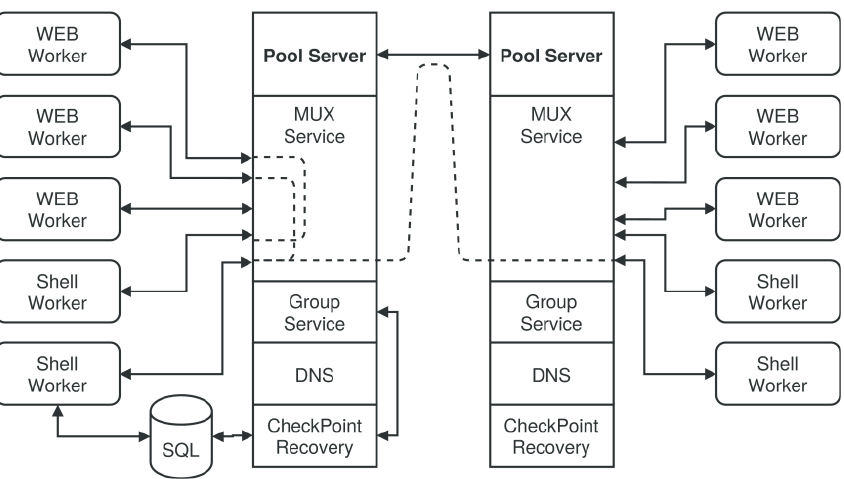
Figure 5. The pool manager server (PMS), managing and connecting worker process groups.